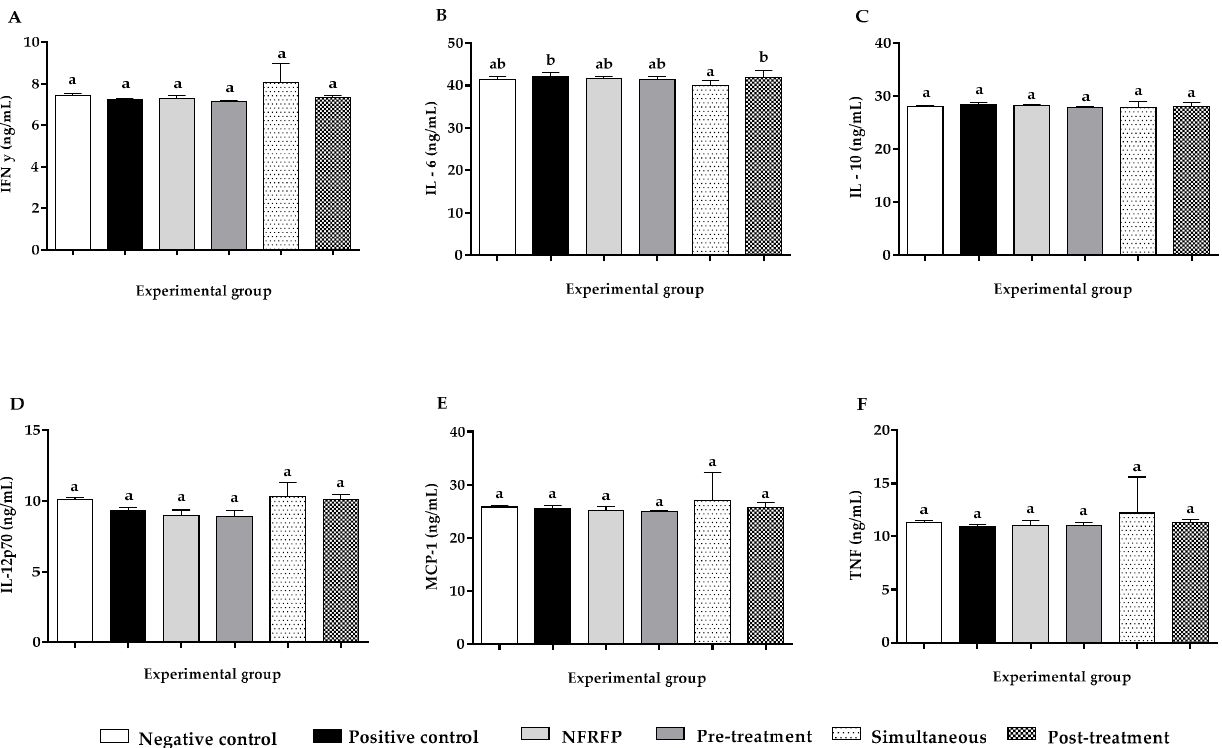
Figure 4. Effect of consumption of the Natural Fiber Rich Food Product (NFRFP) on the expression of the cytokines IFN-y ( A ), IL-6 ( B ), IL-10 ( C ), IL-12p70 ( D ), MCP-1 ( E ) and TNF- α ( F ) in rats treated with 1,2-dimethylhydrazine (DMH). Different letters indicate statistically significant differences (Statistical Test: ANOVA/Tukey; p <